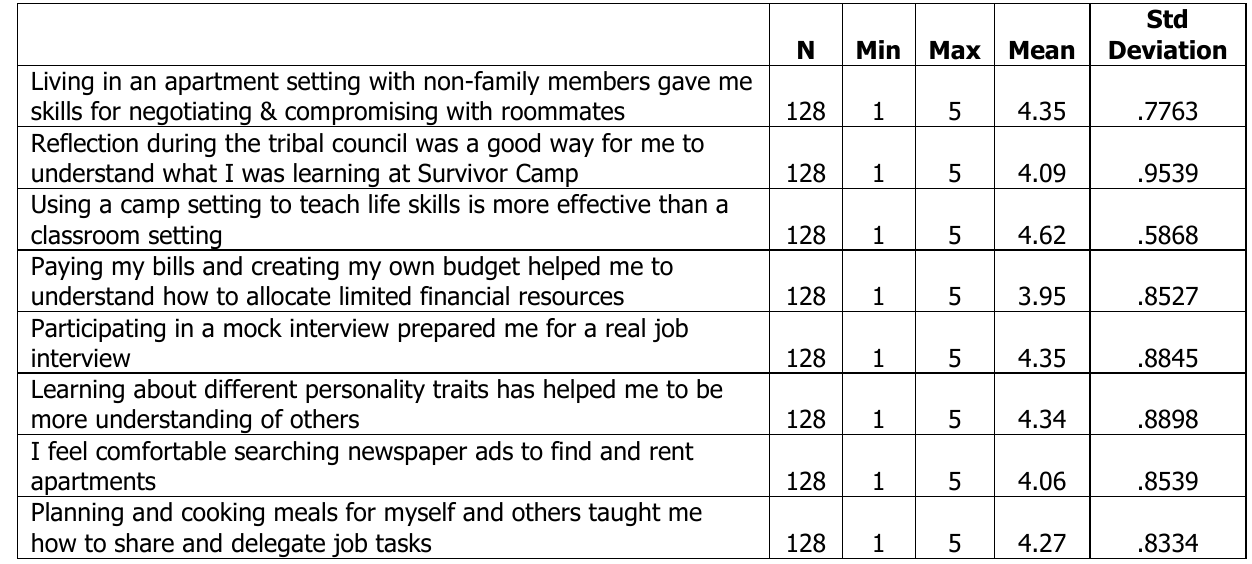
Std N Min Max Mean